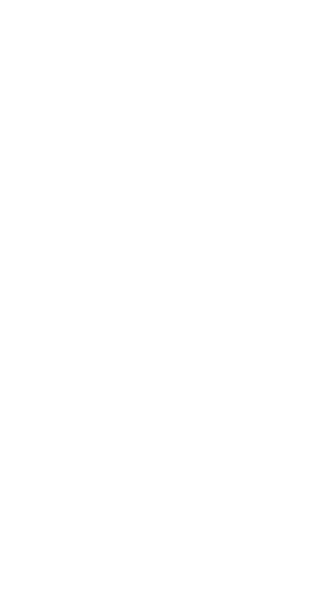
The cognitive scores did not differ between participants with positive and negative vA β (Table 1) and were not correlated with any of the A β SUVR values (correlation coefficients